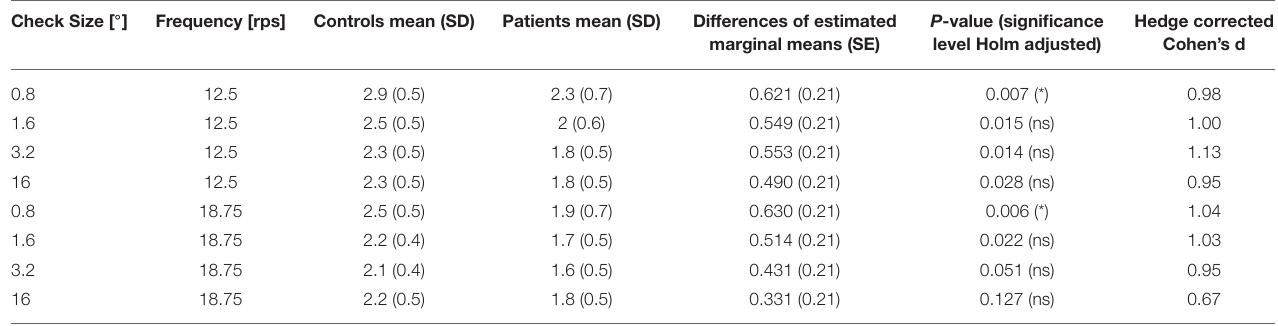
TABLE 3 | Results from the post-hoc analysis for PERG amplitudes (in µ